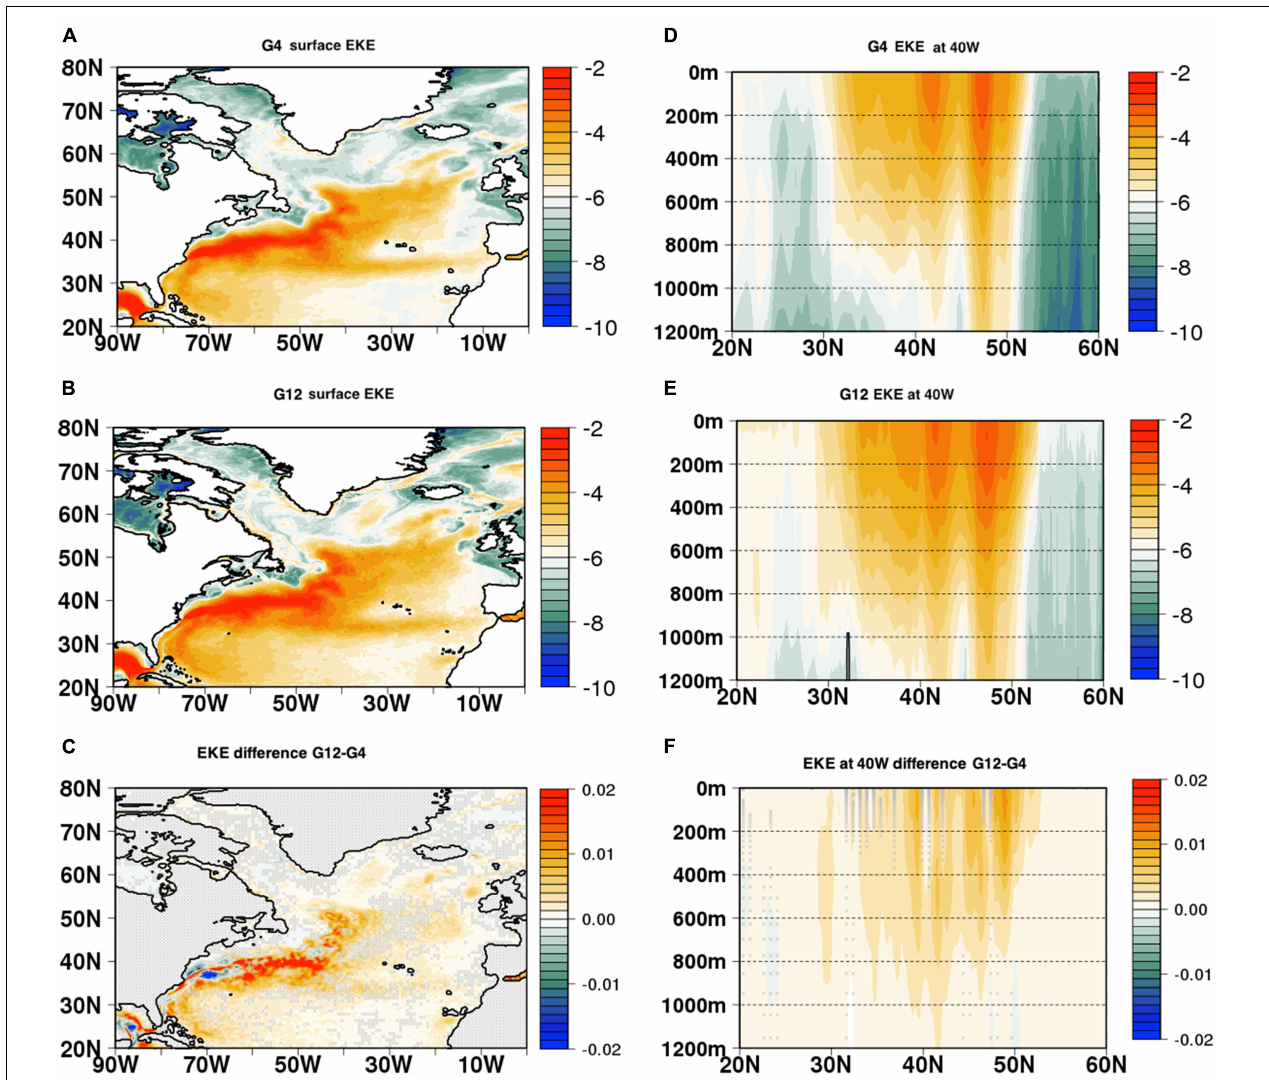
FIGURE 3 | Eddy kinetic energy (EKE) climatology (1993–2016) in (A) G4 and (B) G12 at the surface, (C) the surface EKE difference between G12 and G4, (D) EKE at 40 ◦ W in G4, (E) EKE at 40 ◦ W in G12 (F) the difference between G12 and G4 from surface to 1,200 m at 40 ◦ W. The analysis is based on monthly data. In panels (E,F) areas with values that do not pass t -test 95% confidence interval are indicated with light gray crosses (Unit: log m2/s2 for EKE and m2/s2 for EKE